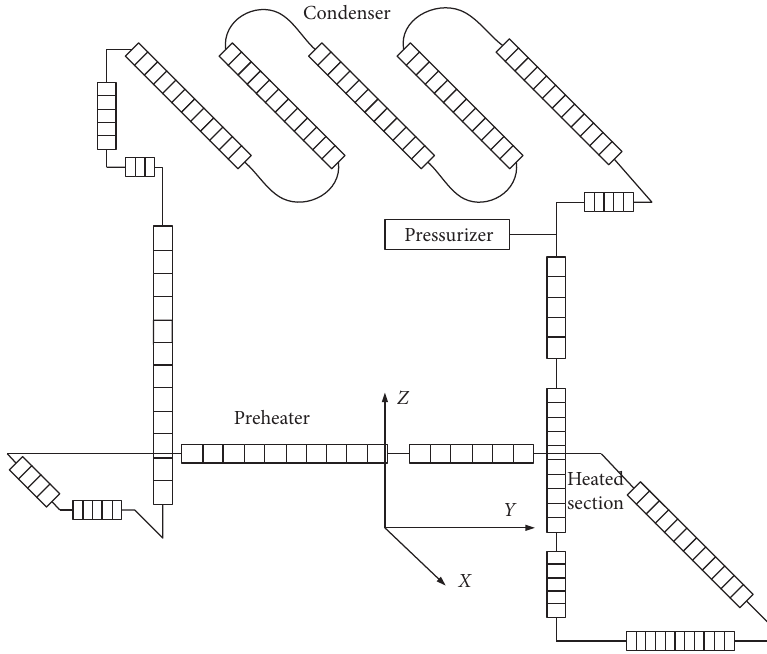
Figure 5: Schematic diagram of the nodalization of the system.